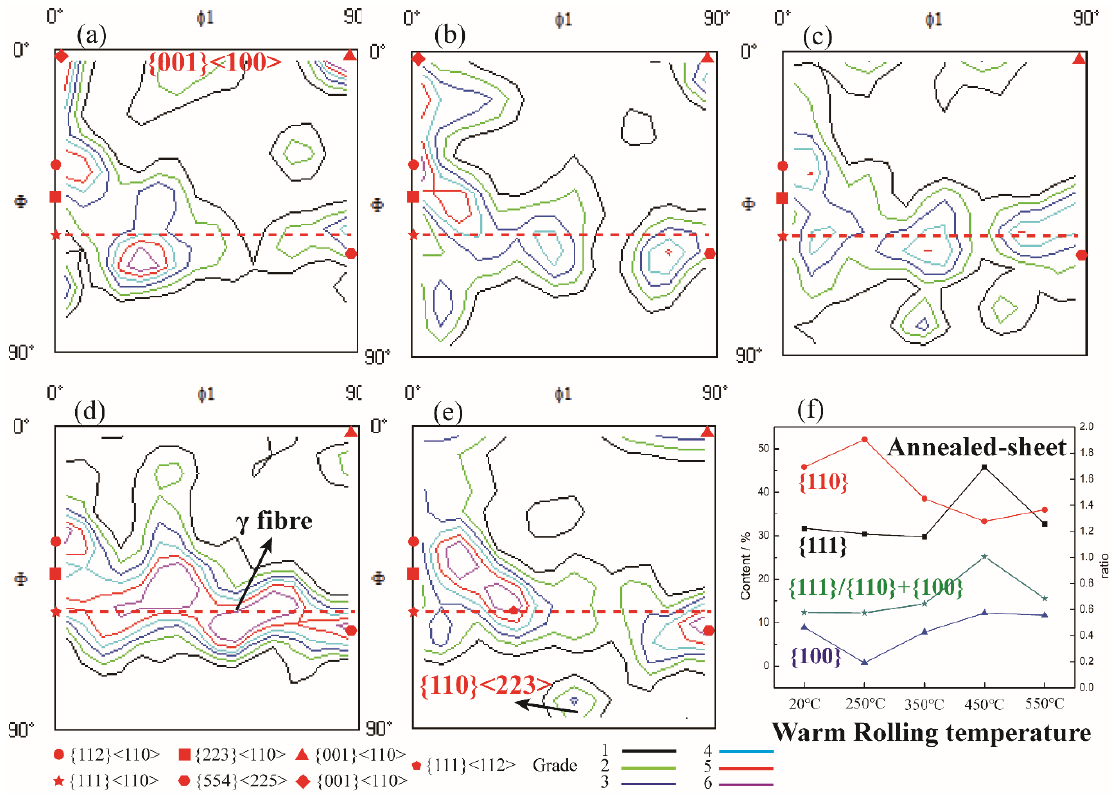
Figure 6. Annealing textures for the specimens. ( a ) RT: strong cubic component; ( b ) 250 °C: weak γ and strong α; ( c ) 350 °C: same conditions as 250 °C; ( d ) 450 °C: strong γ-fiber; ( e ) 550 °C; and ( f ) annealing texture volume fraction.